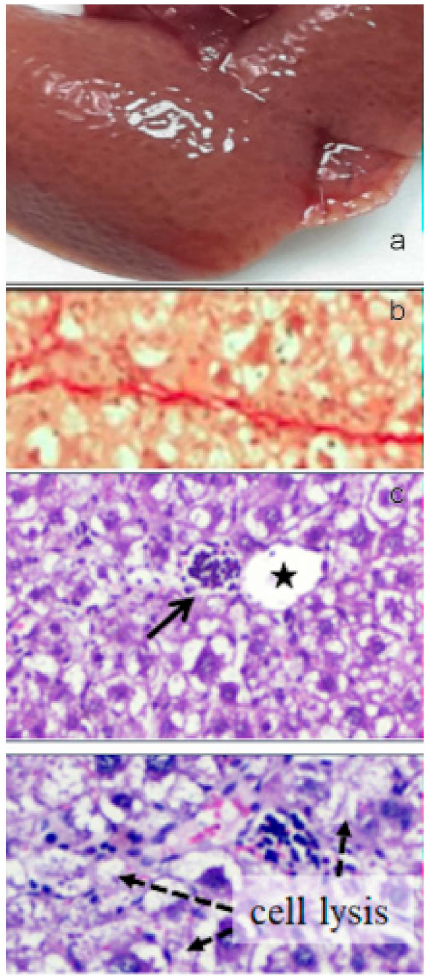
Figure 13. ( a ) Image of the gross morphology of the liver showing altered macroscopic characteristics in CCl 4 challenged group with swollen and spongy appearance of the liver and lobules clearly visible on the surface. ( b ) Picrosirius red staining of liver sections: marked parenchymal deposition of collagen fibers with portal-to-portal bridging fibrosis. ( c ) Several glomerular clusters of inflammatory cells were present in the peri-portal region (upper image, arrow) and nearby focal areas of hepatocellular lysis (bottom image). Asterisk indicates the central vein and star indicates the portal vein. Bar 50 µ